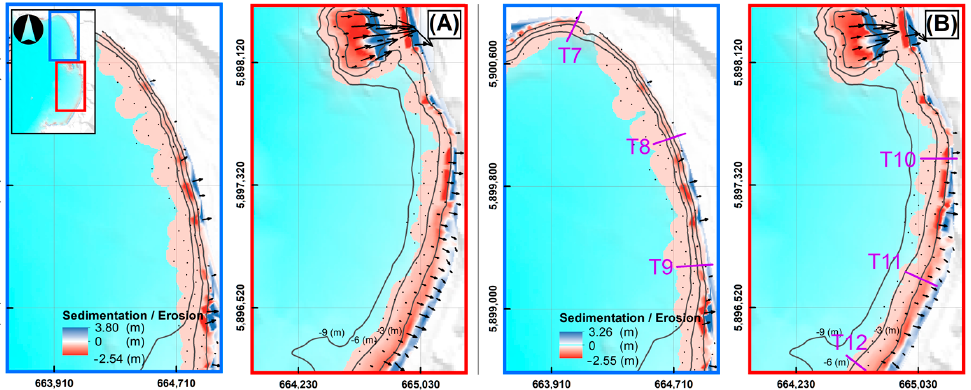
Figure 13. Morphological changes in Coronel during: ( A ) winter and ( B ) summer. Coronel beach is divided into two zones: north (blue box) and south (red box), as in Figure 12. T7–T12 are control transects at Coronel beach.